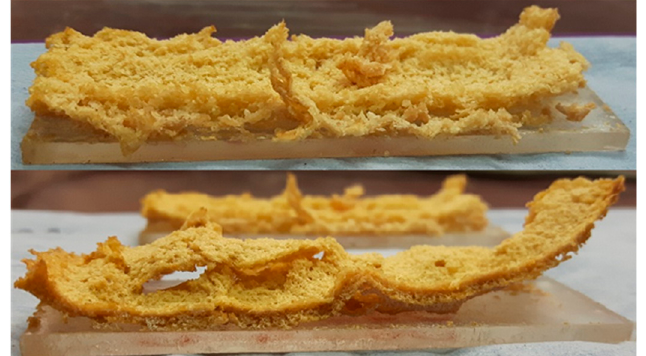
Figure 11. Coatings of PVPA/10% chitosan ( top ) and PVPA/20% chitosan ( bottom ) applied to PMMA after water soak testing.